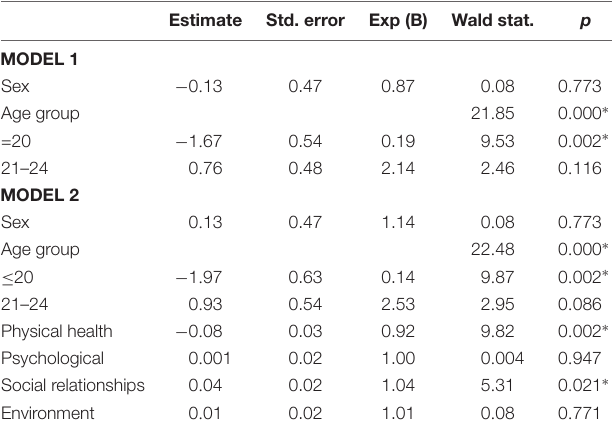
TABLE 5 | Multivariate logistic regression on the four WHOQOL-BREF dimensions controlling for sex and age. Estimate Std. error Exp (B) Wald